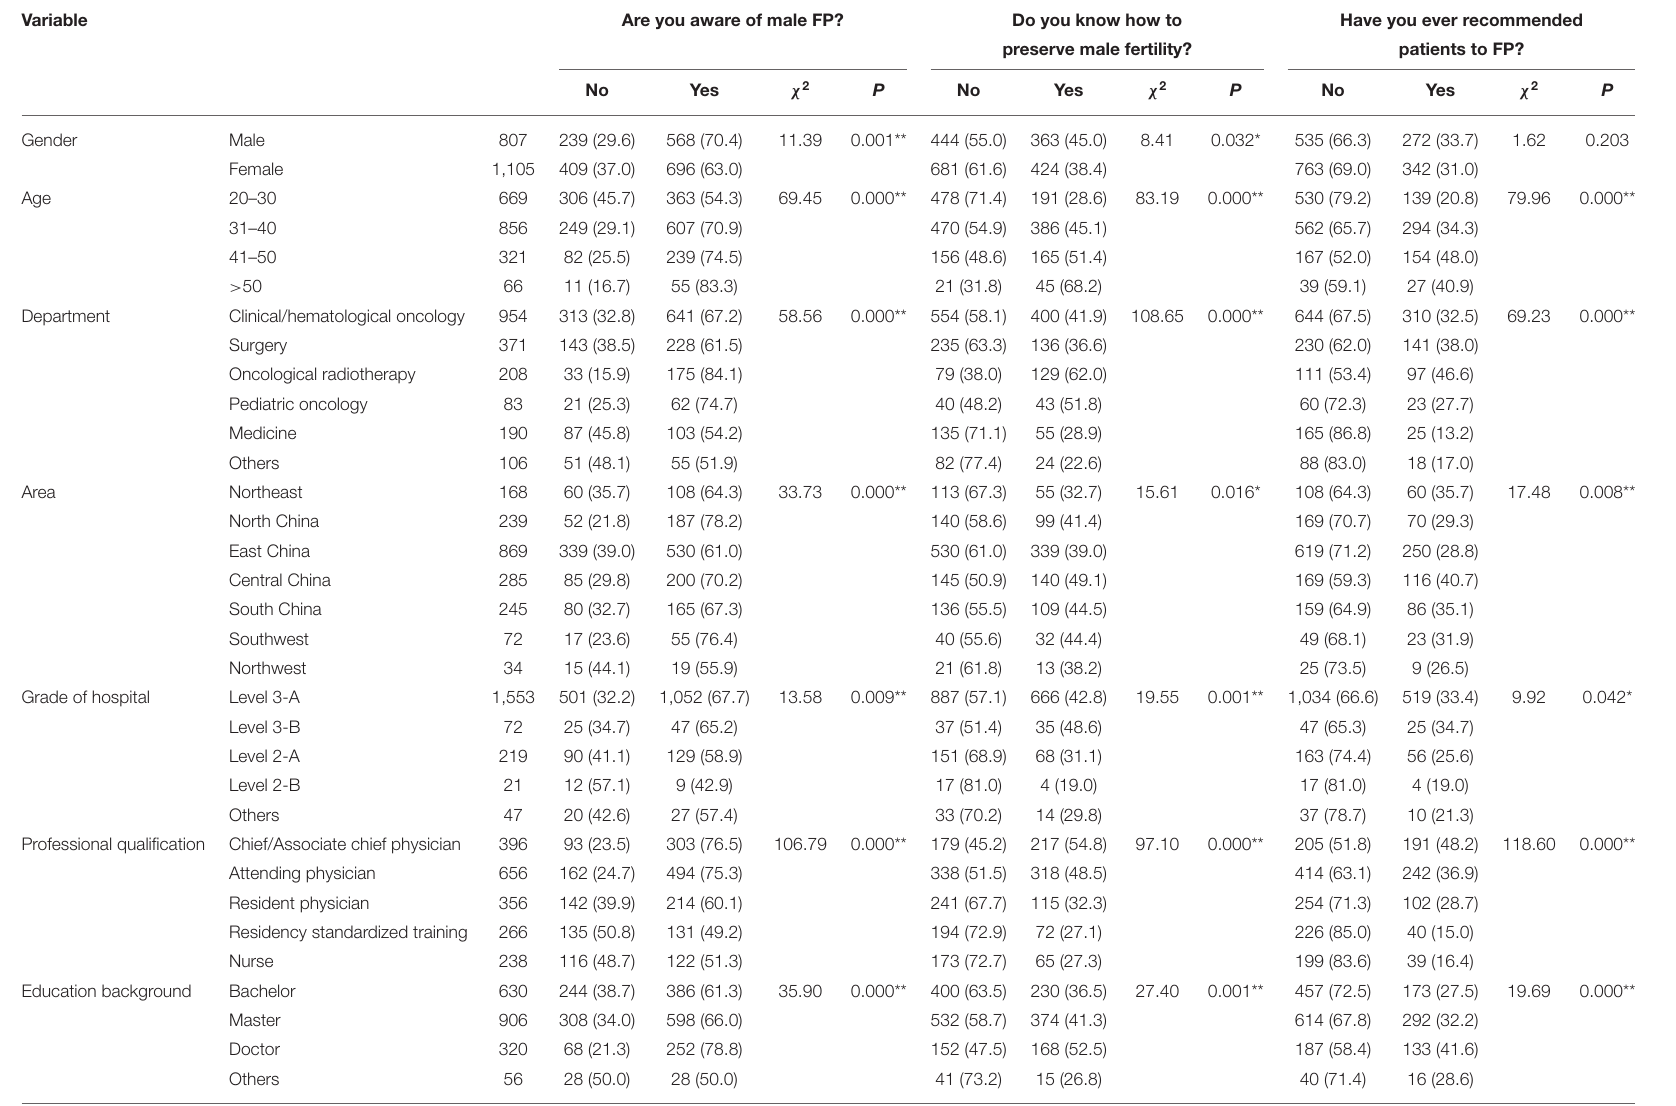
TABLE 3 | Univariate analysis of male fertility preservation cognition and practice by different characteristics of respondents [ N (%)] a . Variable Are you aware of male FP? Do you know how to Have you ever recommended preserve male fertility? patients to